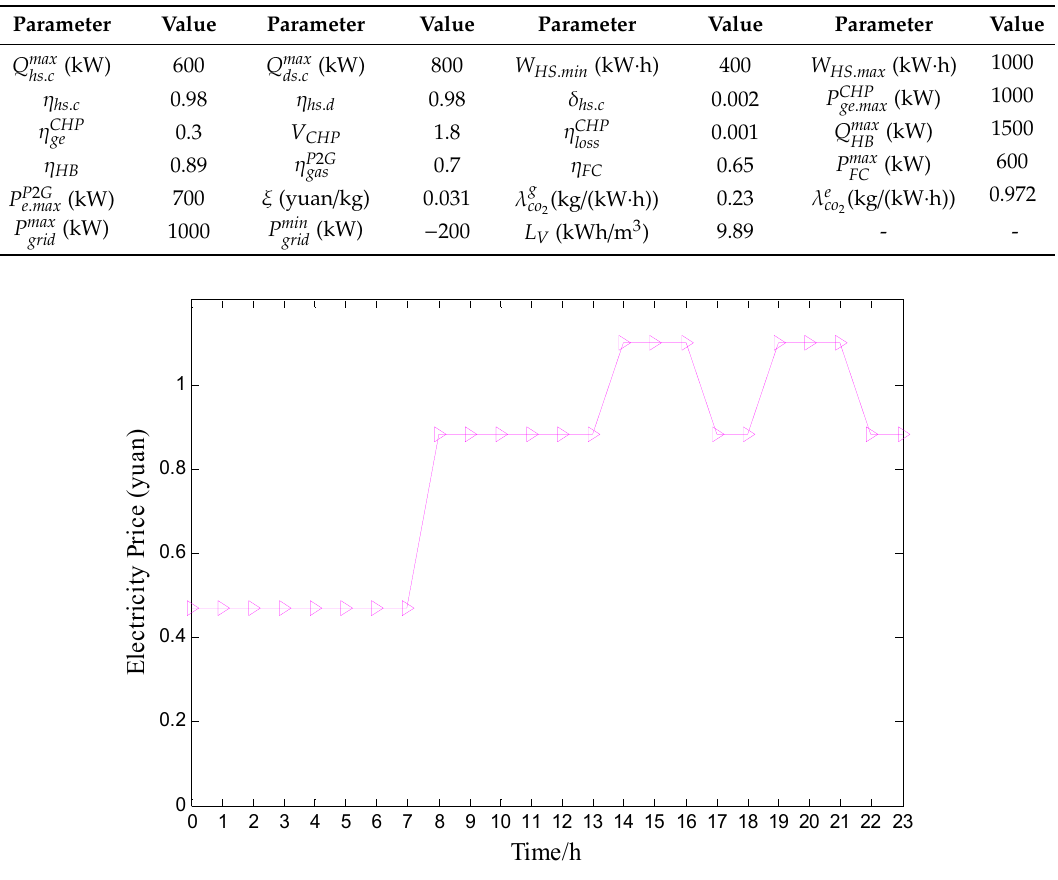
Figure 6. The time-sharing electricity price of a day.